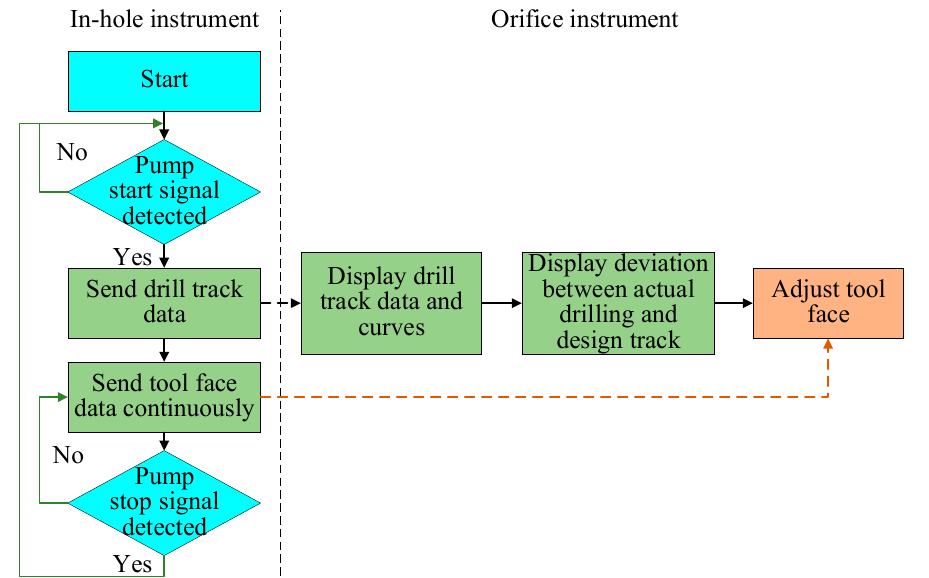
Figure 7. Working principle of mine mud pulse wireless MWD system.